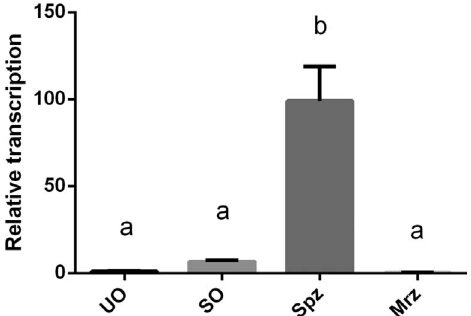
Figure 4. Transcription levels of Et CHP18905 in different devel- opmental stages of E. tenella . UO, unsporulated oocysts; SO, sporulated oocysts; Spz, sporozoites; Mrz, merozoites. Bars with different letters indicate signi fi cantly different expression levels ( p < 0.05) and the error bars indicate standard